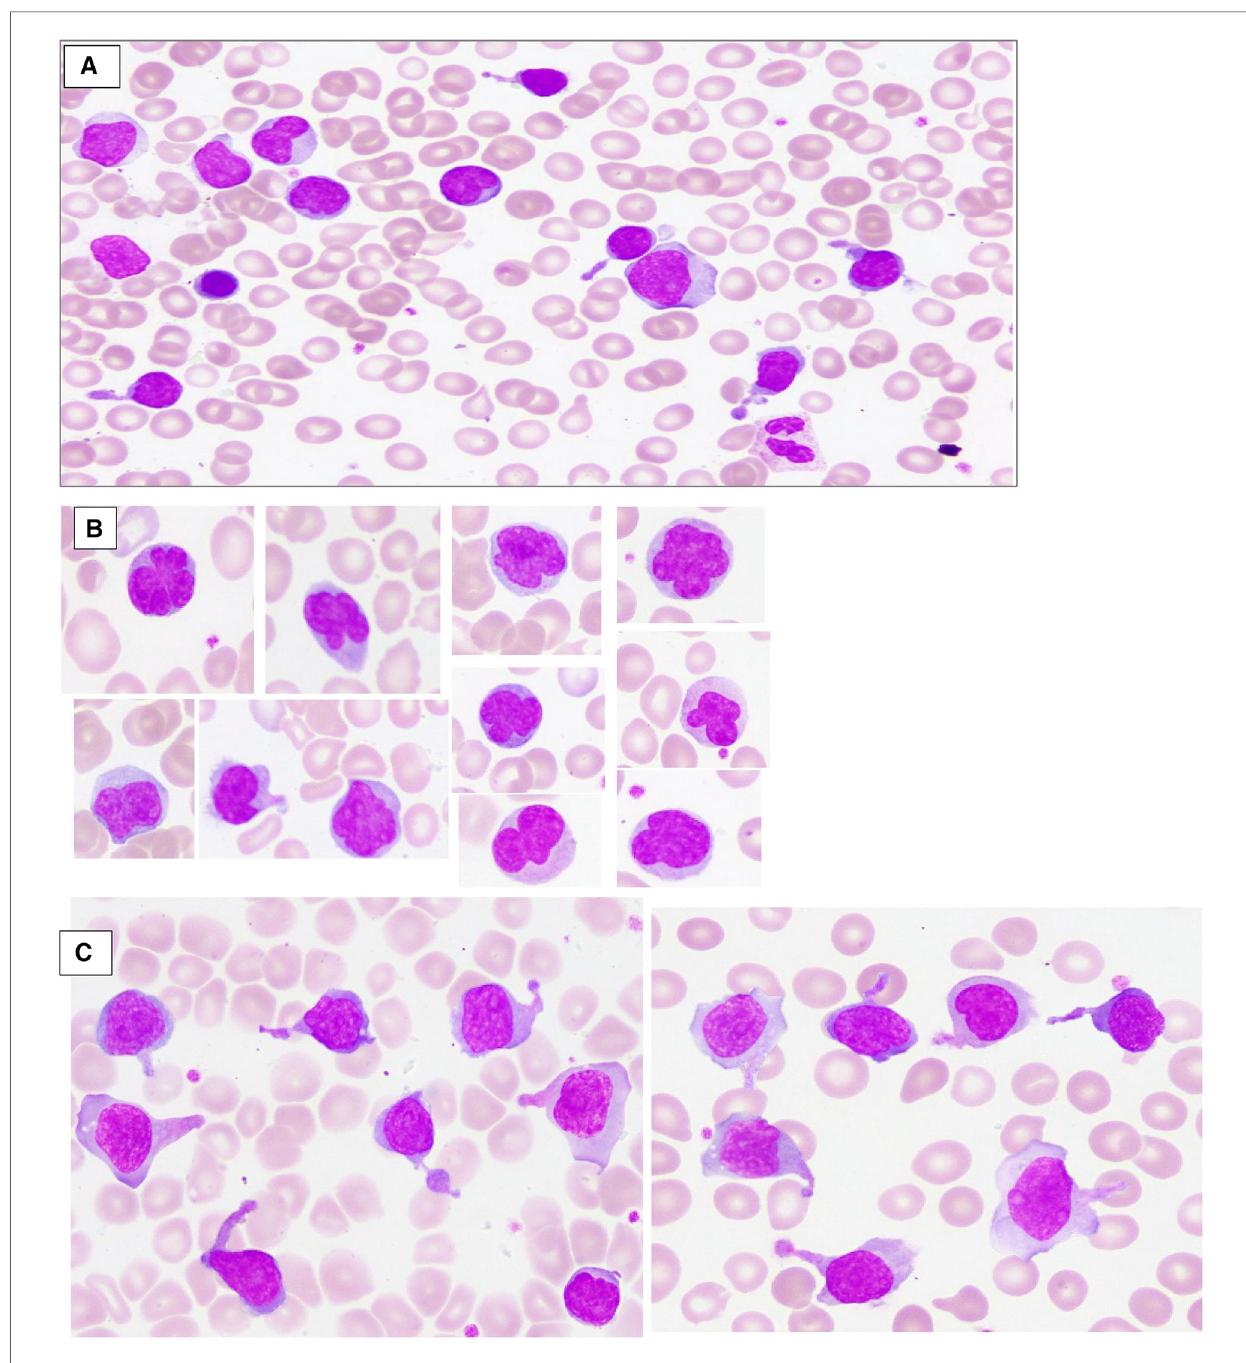
Figure 2B , which was gated on the CD4 − CD8 − DNTs, con fi rmed that the DNTs were predominantly αβ -TCR-positive (95.75% of DNTs) rather than γδ -TCR-positive (4.17%). For further characterization of DNTs, the fi ndings were corroborated by fl ow cytometry performed on peripheral blood at a